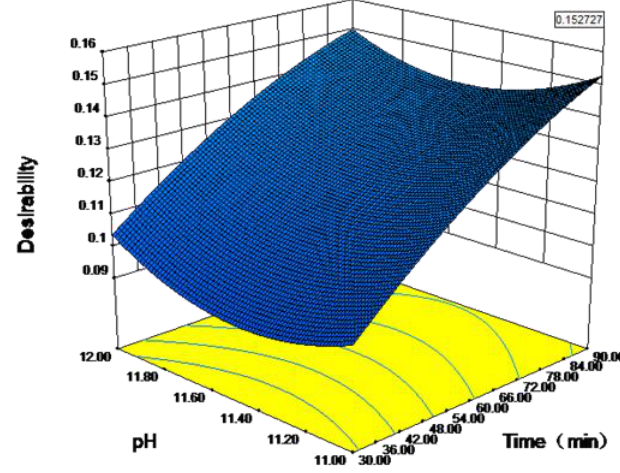
Figure 9. Response surface plot of the desirability function with different pH values and stripping time.